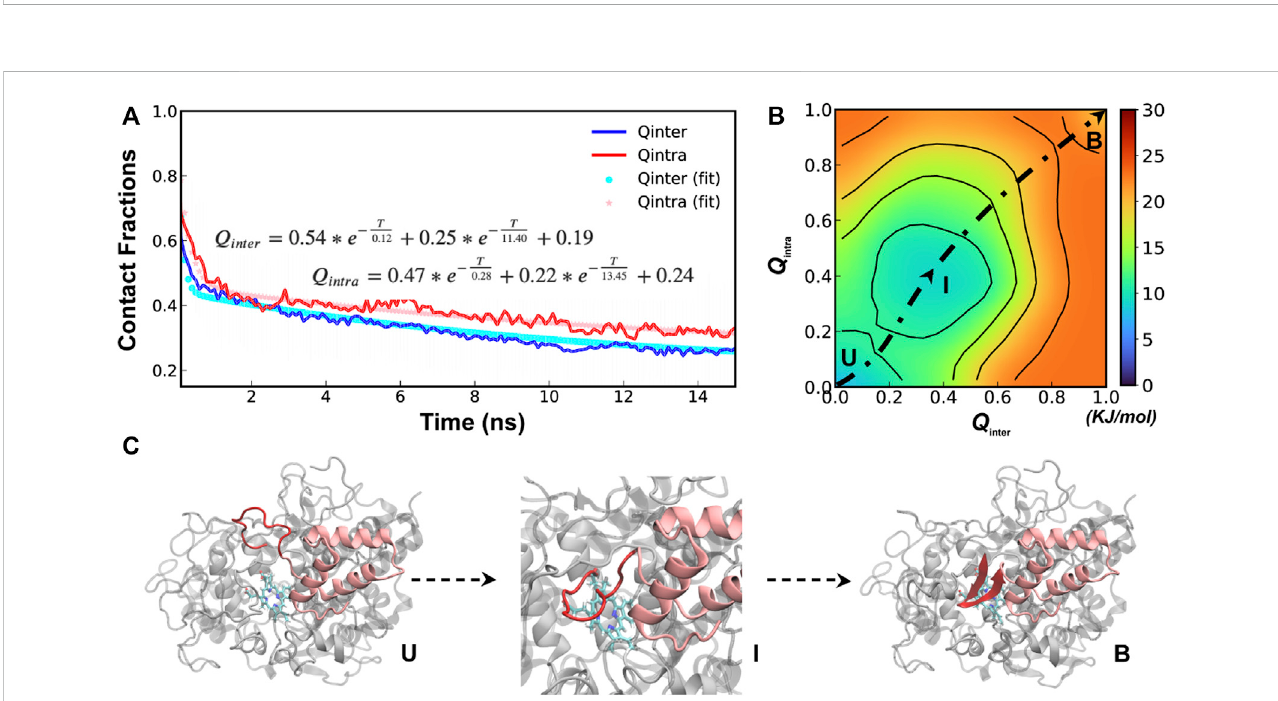
FIGURE 3 Cooperative binding and folding of SPIN- aureus NTD. (A) Average intramolecular and intermolecular native contact fractions ( Q inter and Q intra ) as a function of simulation time at 450 K. The double exponential fi ts are plot using dotted lines, with the actual parameters also shown. (B) Pseudo free energy surface as a function of Q inter and Q intra derived from the transition paths (see Methods). The dashed line indicates the minimum free energy pathway. Key states (U, I and B) are also labeled. (C) Representative conformations for key states along the minimum free energy path, with SPIN- aureus and MPO shown in red and light grey,